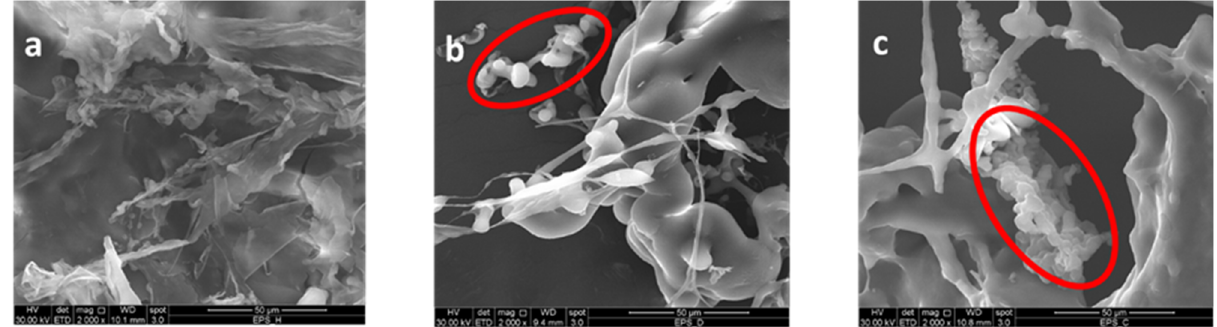
Figure 4. SEM micrographs of EPSH ( a ), EPSD ( b ), and EPSC ( c ) samples. Bar scale for all pictures is 50 μ m.